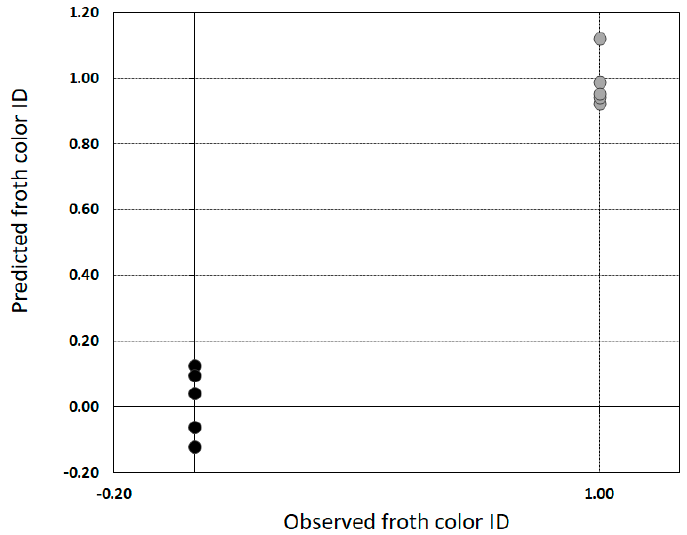
Figure 10. Scatter plot of observed and predicted froth color ID. Black circles = samples with dark froth; grey circles = samples with brown froth.